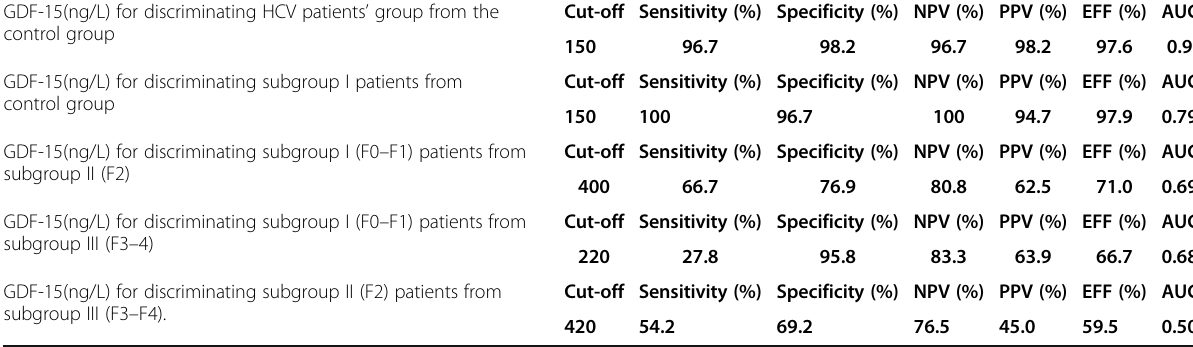
Table 5 Diagnostic performance of GDF-15 as a marker of liver fibrosis for discriminating different groups GDF-15(ng/L) for discriminating HCV patients ’ group from the control